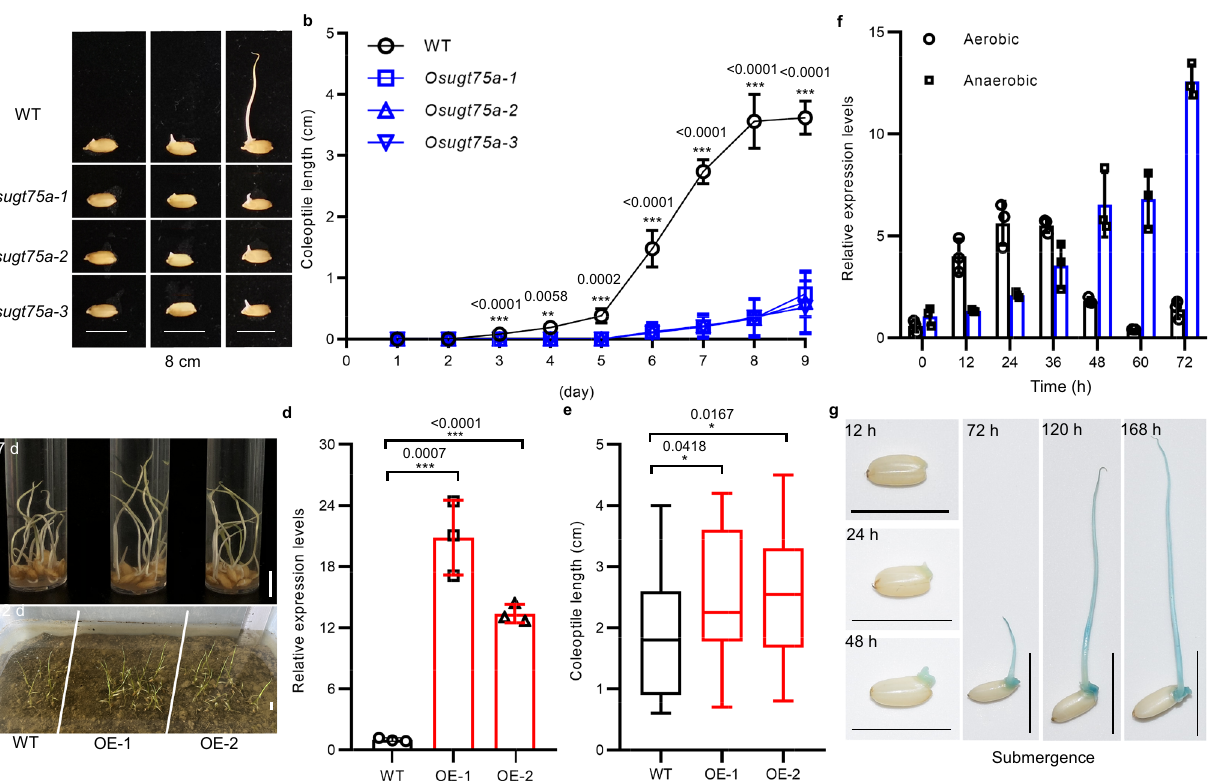
Fig. 2 | Characterization of the regulation of rice coleoptile length under sub- mergence by OsUGT75A . a Representative images of coleoptile length and b dynamic changes in coleoptile length among Nipponbare wild-type (WT) and Osugt75a mutant under submergence (8cm depth of water). Data were presented as mean±SD, n =5. c Representative images of coleoptile length under sub- mergence (8cm depth of water) for 7 days and seedling establishment of direct seeding in soils under submergence (4cm depth of water) for 12 days among WT and overexpressed OsUGT75A lines (OE-1 and OE-2). d Comparison of the relative expression levelsof OsUGT75A in WT and overexpressed lines determined by qRT- PCR analysis. Data were presented as mean±SD, n =3 biologically independent samples. Expression is shown relative to that in the WT, the value of which was set to 1, with the OsActin gene being used as an internal control. e Comparison of the